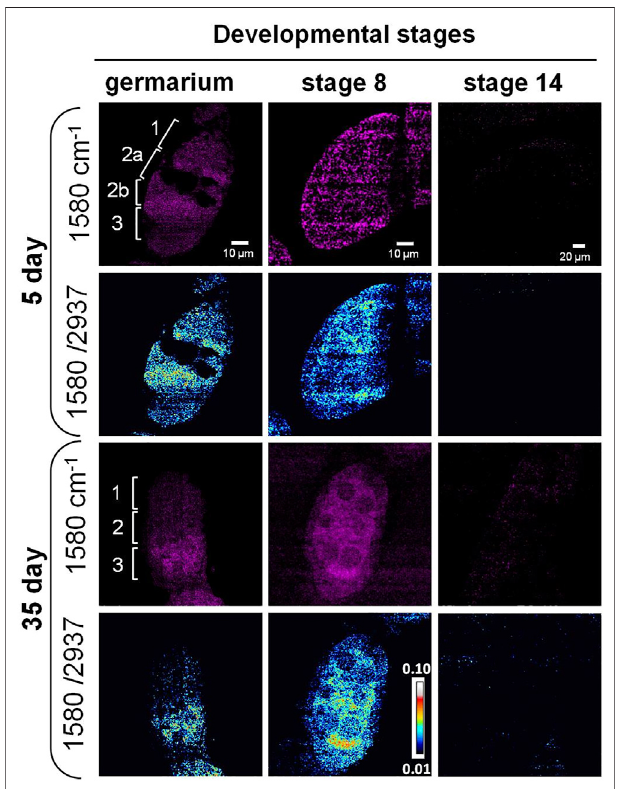
FIGURE 4 | SRS imaging of Cytochrome c distribution in aging Drosophila ovary. SRS imaging at 1,580 cm − 1 in 5- and 35-day ovaries. The ratiometric images of 1,580 cm − 1 /2,937 cm − 1 were used to evaluate the concentration and distribution of Cytochrome c. In day 5 germarium, Cytochrome c was detected in the germ stem cell niche and the developing cysts. However, in old fl ies, the overall level of Cytochrome c was decreased, especially in region 1 where germ stem cell niche was localized. At stage 8, Cytochrome c showed a clear mitochondrial pattern in the nurse cells in both young and old ovaries, which is consistent with its in situ localization to the intermembrane space of these organelles. In the young ovary, Cytochrome c was evenly distributed in the cytoplasm of nurse and follicle cells at stage 8, while its signal level was upregulated in the nurse cells and reduced in the follicle cells in old ovaries. Inside the nurse cells, Cytochrome c was more evenly distributed in young fl ies but more condensed in old fl ies. Scale bar, 10 µm in germarium and stage 8, and 20 µm stage 14.